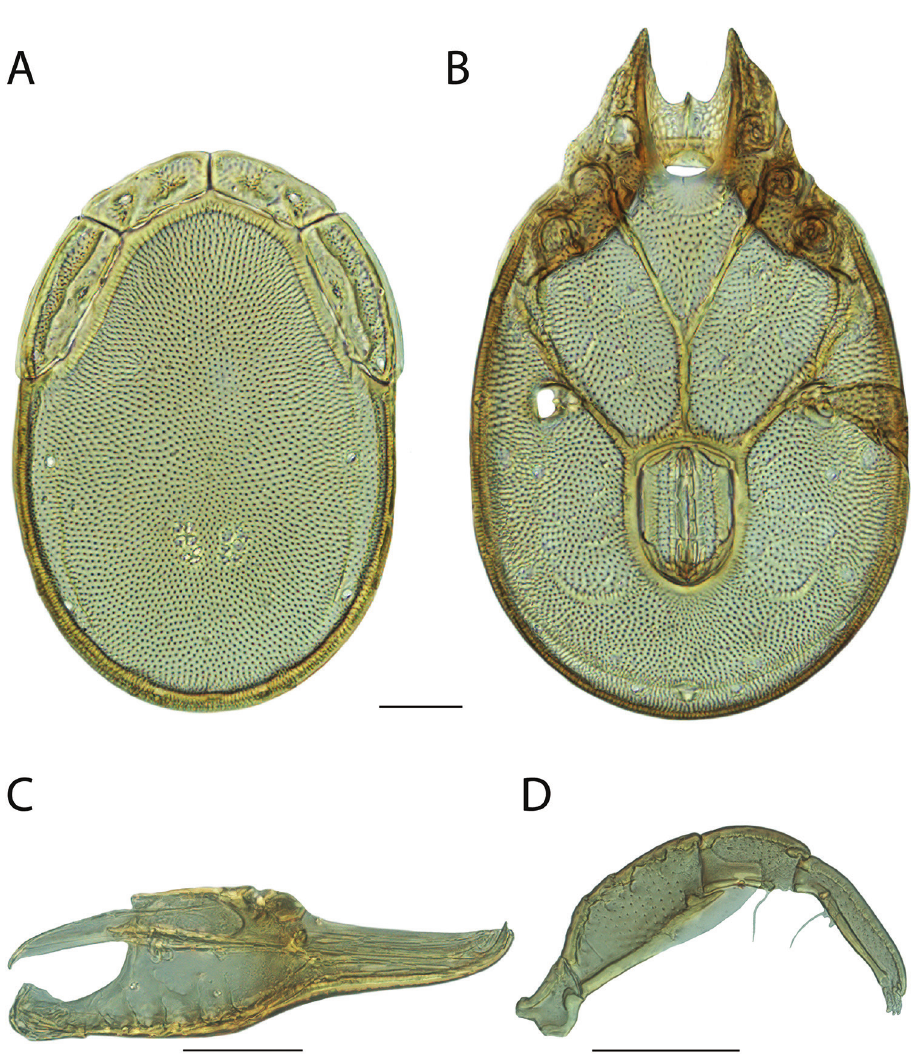
Figure 125. Torrenticola lamellipalpis male: A dorsal plates B venter (legs removed) C subcapitulum D pedipalp (setae not accurately depicted). Scale = 100